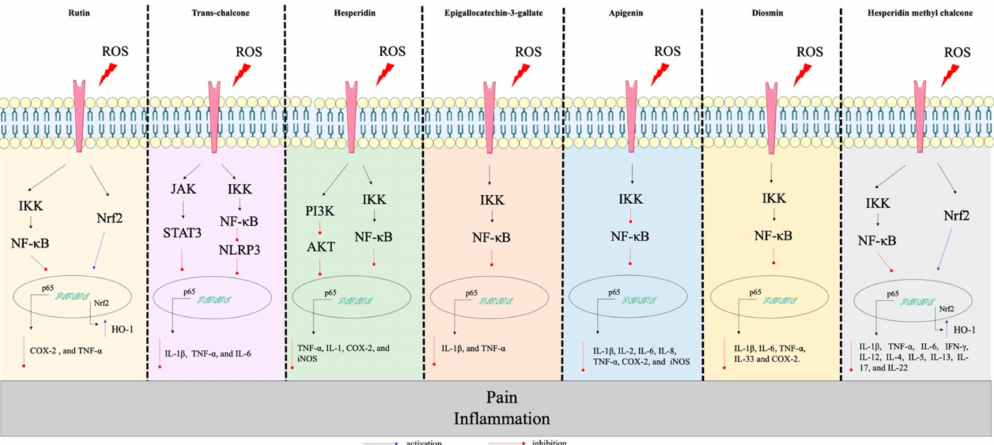
Figure 3. The anti-inflammatory and analgesic e ff ects of flavonoids. Intracellular targets of Rutin : NF- κ B [39,40] and Nrf2 [40], Trans-chalcone : NF- κ B [41] and STAT3 [41] and NLRP3 [42], Hesperidin: PI3K / AKT [43] and NF- κ B [44], Epigallocatechin-3-gallate: NF- κ B [45], Apigerin : NF- κ B